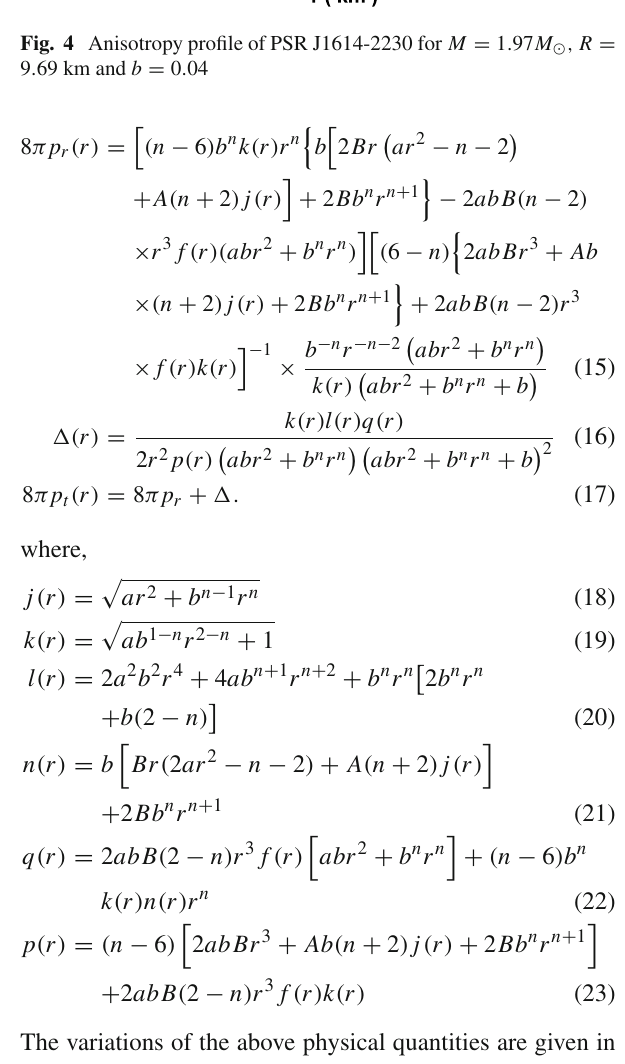
Fig. 3 Radial and transverse pressure profile of PSR J1614-2230 for M = 1 . 97 M (cid:6) , R = 9 . 69 km and b = 0 . 04